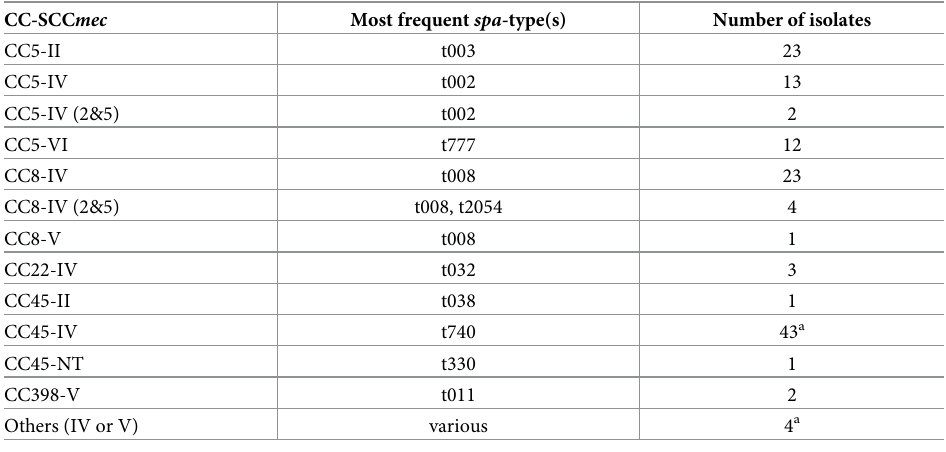
Table 2. Molecular typing of methicillin-resistant Staphylococcus aureus (MRSA) isolates (n = 132) in 29 Belgian nursing homes,